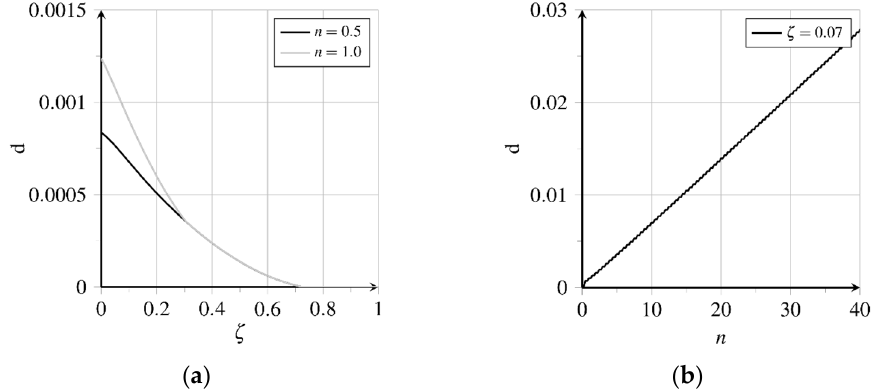
Figure 12. Evolution of relative displacements (adapted from [27]): ( a ) Displacement distribution over bond length in first load cycle and ( b ) displacement evolution near the fibre outlet at further load cycles.